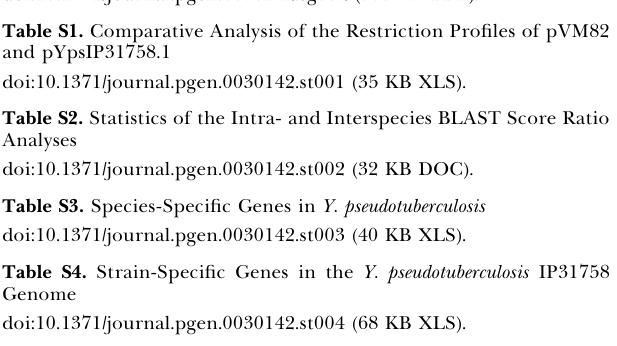
Figure S1. Circular Representation of the Y. pseudotuberculosis IP32953 Genome From outer to inner circle. Circle 1 and 2 predicted open reading frames encoded on the plus (circle 1) and minus strands (circle 2), colored according to the respective TIGR role IDs (http://cmr.tigr.org/ tigr-scripts/CMR/RoleIds.cgi). (Circle 3) Noncoding RNAs. Brown, tRNA genes; black, ribosomal rRNAs. (Circle 4) GC skew. (Circle 5) Genomic islands. Violet, species-specific R/M system shared between Y. pseudotuberculosis strains IP31758 and IP32953. (Circle 6) IS elements, transposases, and phage integrases. (Circles 7–13) Com- parative analysis of the genomic inventory. Intraspecies comparison to Y. pseudotuberculosis IP31758 (circle 7) and interspecies comparison Chi square. Figure S2. Phylogenetic Analysis and Taxonomy BLAST of the Complete Genomic Inventory of Y. pseudotuberculosis IP31758 Each of the 4,164 Y. pseudotuberculosis CDSs except the noncoding RNAs were blasted using BLASTP against the NCBI protein database (E-value , 10 (cid:2) 5 ). (A) Taxonomic distribution of each protein. Almost 90% of the predicted Y. pseudotuberculosis proteins do have their closest homolog in the genus Yersinia, and only a minority of 3% in other microbes. For 9% of the genes, no database homologs were found. (B) Gene acquisition via horizontal gene transfer. The majority of these genes group phylogenetically in the gamma-subdivision of proteobacteria, in particular into the family of Enterobacteriaceae. Table S1. Comparative Analysis of the Restriction Profiles of pVM82 and pYpsIP31758.1 Table S2. Statistics of the Intra- and Interspecies BLAST Score Ratio Analyses Table S3. Species-Specific Genes in Y. pseudotuberculosis Table S4. Strain-Specific Genes in the Y. pseudotuberculosis IP31758